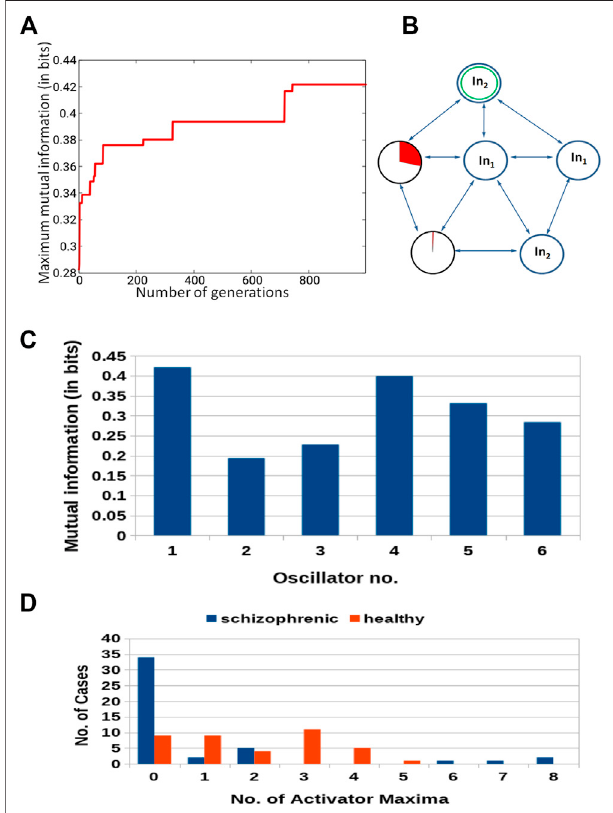
FIGURE 11 | Results for 6-oscillator network (cf. Figure 2D ): (A) The progress of optimization; the Fitness as a function of generation number. (B) The structure of the optimized network. Notation as in Figure 5B . (C) The mutual information I ( G ; O j ) for j ∈ {1,2,3,4,5,6}.The function j → I ( G ; O j ) has the maximum at j =1. (D) The distribution of the numbers of cases for which a given number of activator maxima was observed on oscillator #1 for records representing schizophrenic and healthy